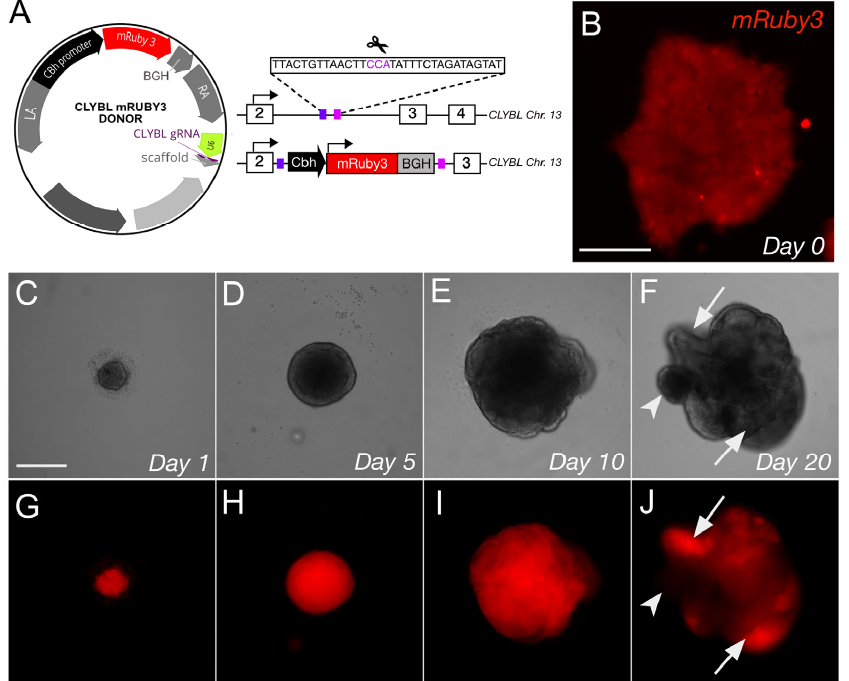
Figure 6. Safe harbor site targeting. ( A ) A donor plasmid (left) for targeting the intronic region (right) of the CLYBL SHS contains left and right homology arms (LA, RA), a Cbh promoter, mRuby3 and a BGH polyadenylation sequence. A U6 promoter drives the expression of a CLYBL -specific guide RNA for gene targeting. ( B ) Fluorescence of Cbh-mRuby3 integrated at the CLYBL SHS in undifferentiated IMR90 iPSCs and imaged by fluorescence microscopy. ( C – J ) Organoids derived from IMR90.4-HF-iCas9 CLYBL-mRuby3 PSCs over a 20-day period. ( C – F ) Brightfield images were monitored to assess morphology, while ( G – J ) constitutively expressed mRuby3 was monitored to assess the preservation of fluorescent signals over time. Arrows = mRuby3 fluorescence, arrowhead = no signal. Scale bars ( B ) = 100 µ m, ( C – J ) = 200 µ